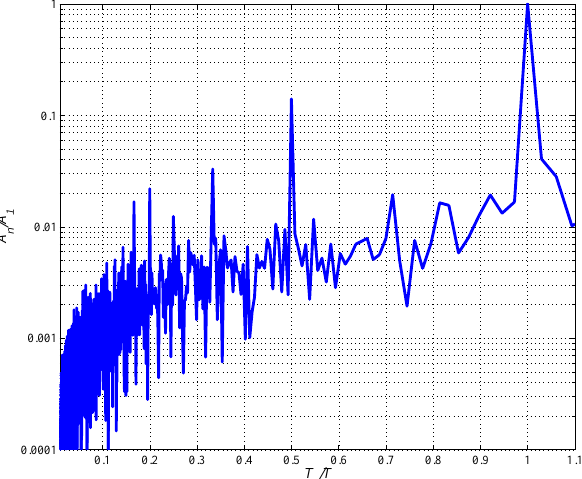
Figure 11. Ratio of the n th order harmonic amplitude to the fun- damental harmonic amplitude A n /A 1 found from the Fourier trans- form of the Arctic sea ice area time series against the ratio of the n th harmonic period to the fundamental harmonic period T n /T . One can see the Arctic sea ice response features prominent second, third, forth, fifth and sixth harmonics in its spectrum.